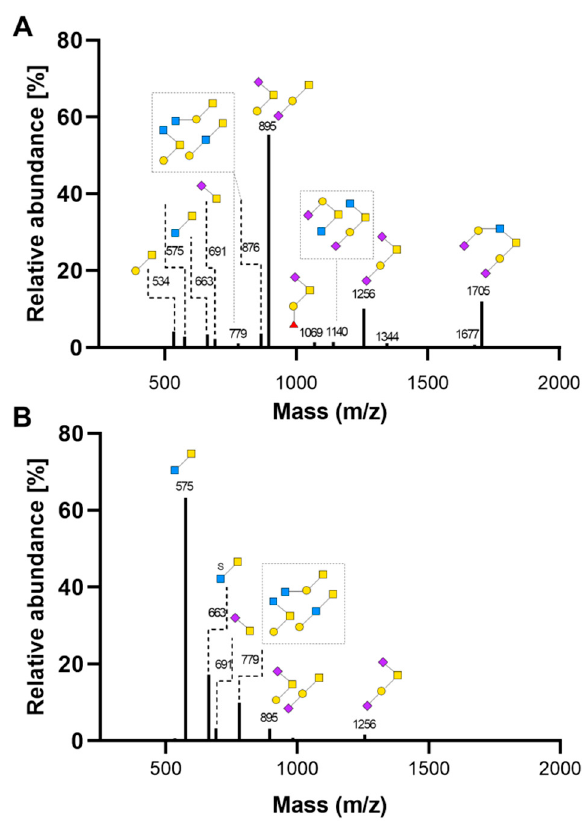
Figure 6. Impact of zinc deficiency on the O-glycosylation pattern of mucins secreted by HT-29-MTX. Cells were cultured for 14 days in zinc-sufficient ( A ) or -deficient medium ( B ). The main glycan